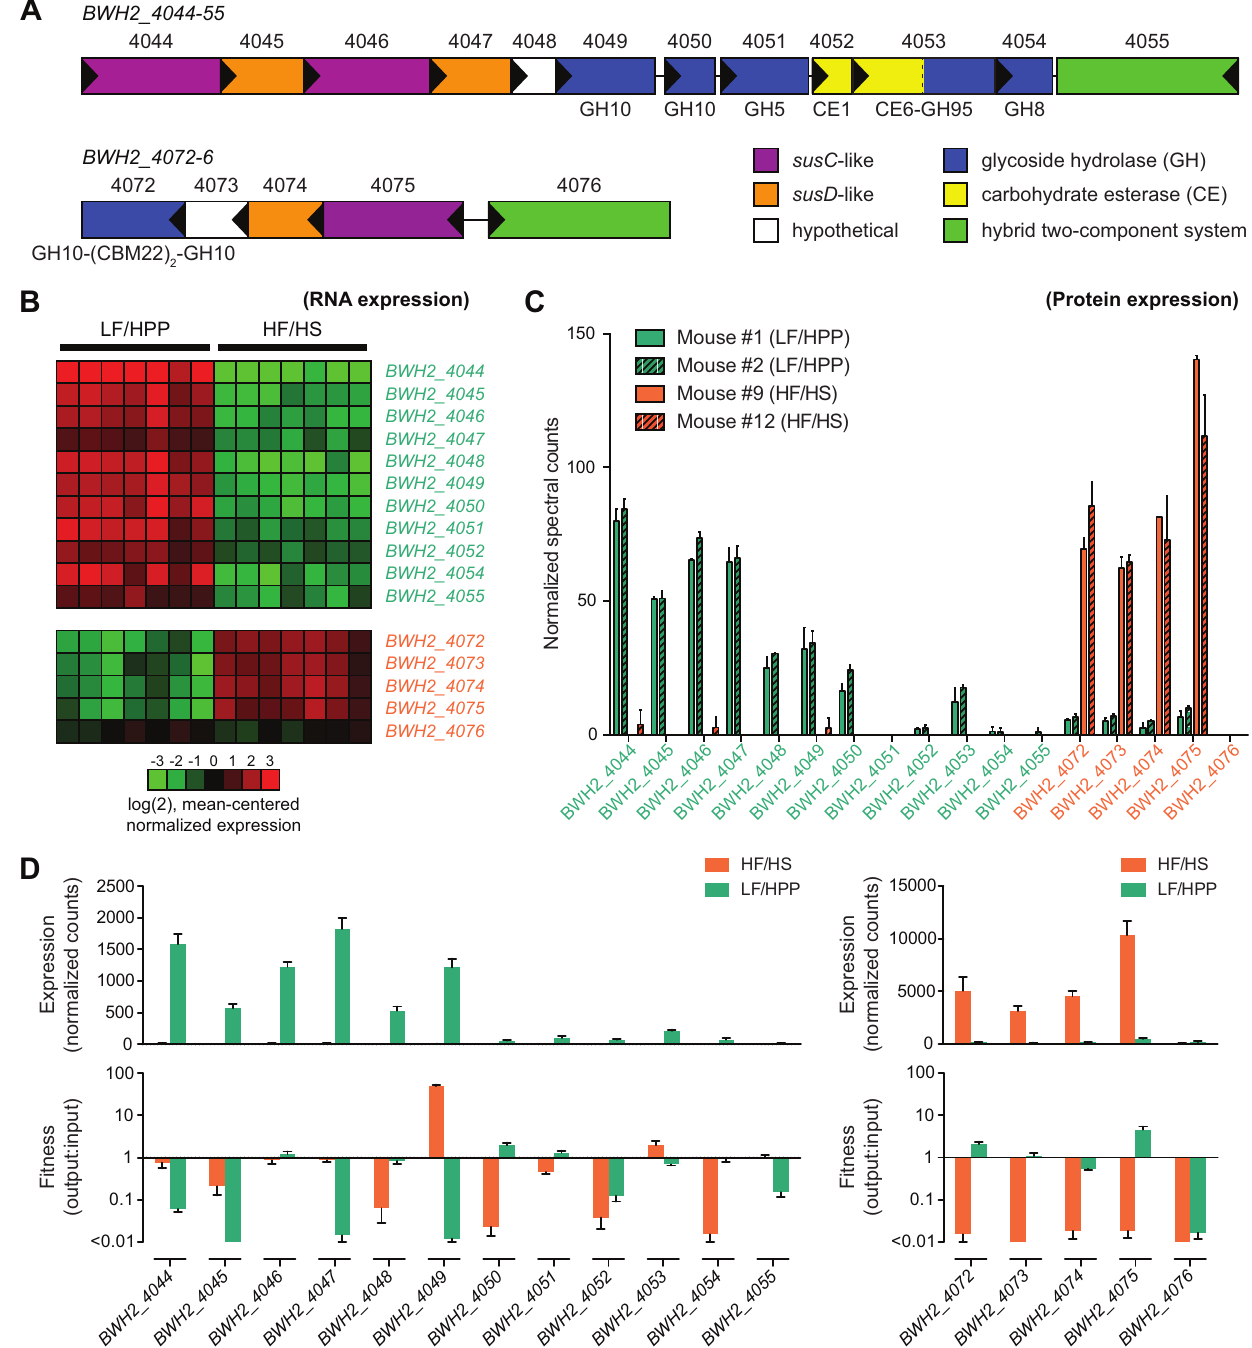
Figure 4. Two xylanase-containing B.cellulosilyticus WH2 PULs demonstrating strong diet-specific expression patterns invivo . (A) The PUL spanning BWH2_4044 – 55 includes a four-gene cassette comprising two consecutive susC / D pairs, multiple genes encoding GHs and CEs, and a gene encoding a putative hybrid two-component system (HTCS) presumed to play a role in the regulation of this locus. GH10 enzymes are endo- xylanases (most often endo- b -1,4-xylanases), while some GH5 and GH8 enzymes are also known to have endo- or exo-xylanase activity. CE6 enzymes are acetyl xylan esterases, as are some members of the CE1 family. A second PUL spanning BWH2_4072 – 6 contains a susC / D cassette, an endo- xylanase with dual GH10 modules as well as dual carbohydrate (xylan) binding modules (CBM22), a hypothetical protein of unknown function, and a putative HTCS. (B) Heatmap visualization of GeneChip expression data for BWH2_4044 – 55 and BWH2_4072 – 6 showing marked up-regulation of these putative PULs when mice are fed either a plant polysaccharide-rich LF/HPP diet or a diet high in fat and simple sugar (HF/HS), respectively. Data are from cecal contents harvested from mice at the endpoint of experiment E 1 . (C) Mass spectrometry-based quantitation of the abundance of all cecal proteins from the BWH2_4044 – 55 and BWH2_4072 – 6 PULs that were detectable in the same material used for GeneChip quantitation in panel (B).